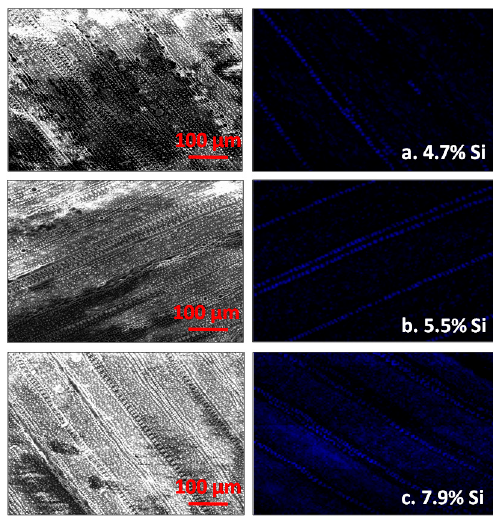
Figure 2. Scanning electron microscope image (400 times magnification) and energy dispersive X-ray (EDX) silicon (blue) mapping of adaxial leaf surface at flowering for check ( a ), foliarly applied silicon at 40 mg L − 1 ( b ), and wollastonite ( c ). Red bar = 100 µm.